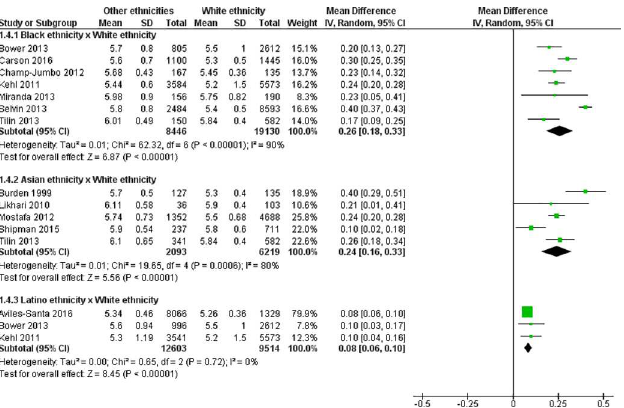
Fig 2. Forest plot diagram of the effect of ethnicity on HbA1c (%) levels in non-diabetic persons; CI = confidence interval; SD = standard deviation.